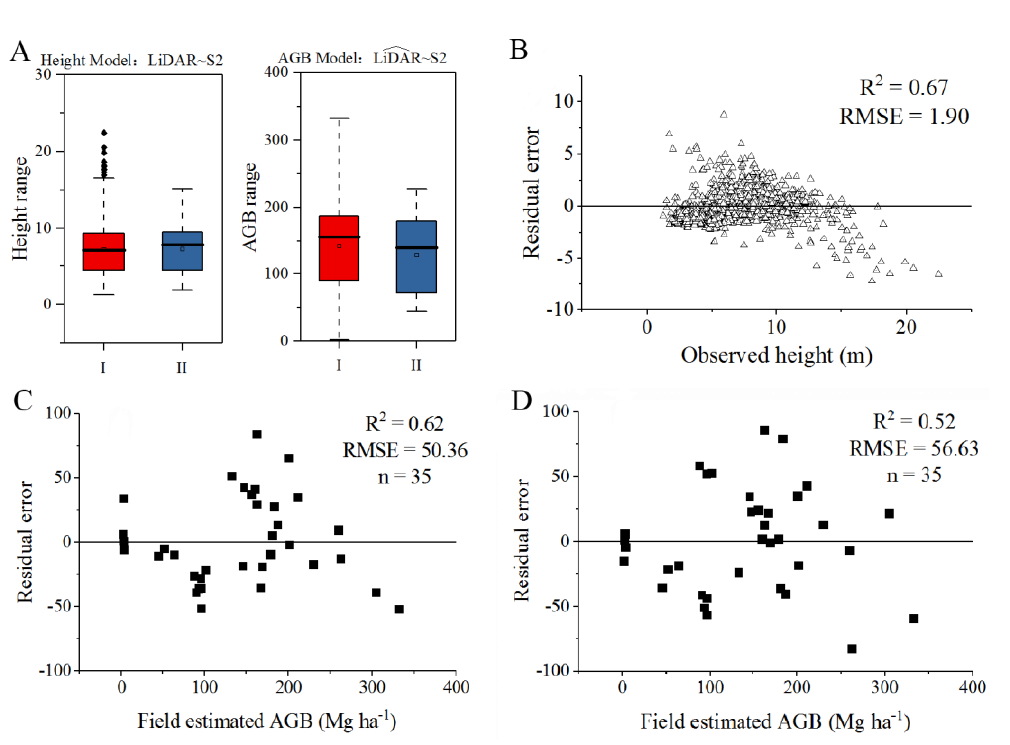
Figure 5. ( A ) Boxplots of the observed (I) and predicted values (II) for mangrove height (LiDAR~S2) and AGB ( ˆLiDAR ∼ S2) models, respectively. ( B ) Scatterplot of the residual error versus observed height values (LiDAR~S2) ( C ) Scatterplots of the residual error versus the field-estimated mangrove AGB for the ˆLiDAR ∼ S2 model; ( D ) Scatterplots of the residual error versus the field-estimated mangrove AGB for the traditional G~S2 model.